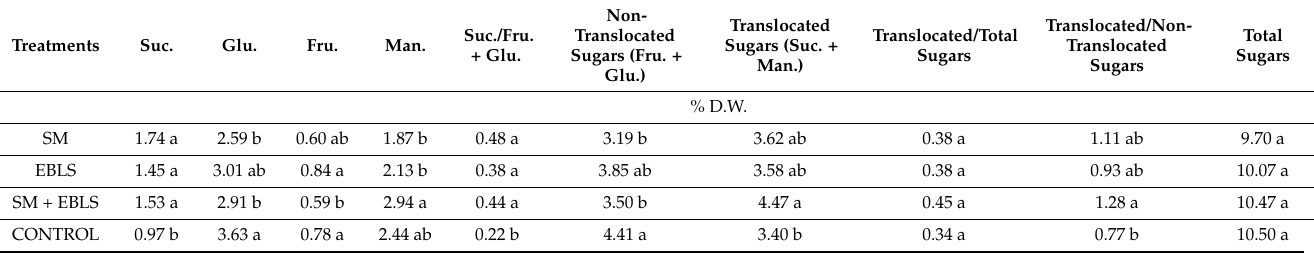
Table 6. Leaf sugar concentrations of the olive plants among the